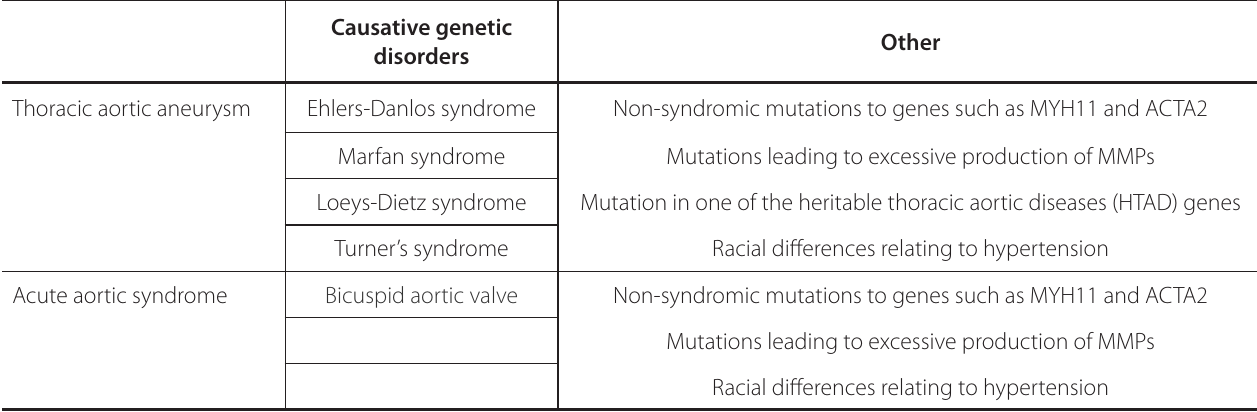
Table 5 . Genetic and non-genetic causes of thoracic aortic pathologies. Causative genetic